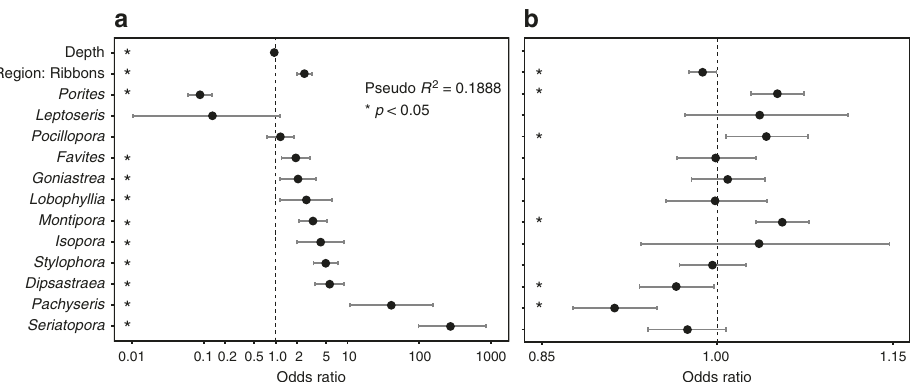
Fig. 5 Odds ratios for the progression of bleaching categories from healthy to bleaching-related mortality. Odds ratios (with 95% con fi dence intervals) produced by the ordinal logistic regression model for ( a ) signi fi cant explanatory variables (depth, region and the different coral taxa), and ( b ) their interactions with depth (signi fi cant for region and coral taxa). OLR is an extension of binomial logistic regression in which multiple categories associated with an ordinal event are attributed an odds ratio statistic — the probability of the occurrence of that event based on a combination of one or more independent variables. Odds ratios for region refer to Far Northern GBR as the reference (combining Great Detached and Tijou) and for coral taxa to Acropora (corresponding to an odds ratio of one). An asterisk (*) marks categories or interactions for which log odds (and ratios) are signi fi cantly different from those of reference categories. Note the very narrow con fi dence intervals for depth in panel a , which do not overlap with the unit of odds ratio, therefore con fi rming the statistical signi fi cance of this variable. Location had no signi fi cant effect on the progression of bleaching as tested by OLR and individual locations were therefore grouped into two regions. The full model, including interaction effects between depth and each of the other two signi fi cant variables, region and coral taxa, explained 18.9% of the variation in the dataset. Depth, coral taxa and region explained 1.4%, 17.3% and 1.1% of the variation in bleaching response, respectively. The interactions depicted in panel b mean that the different coral genera do not respond homogeneously over depth, and that the effect of depth is not homogeneous between regions. See Supplementary Figure 4 for further modelling